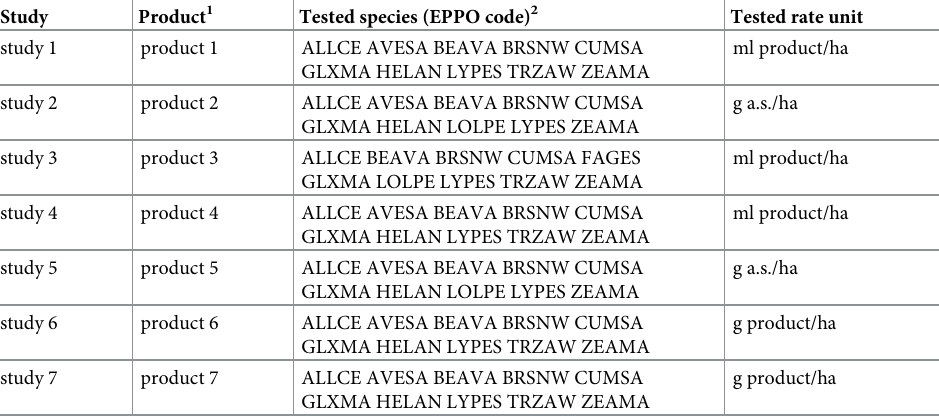
Table 1. Brief description of the seven